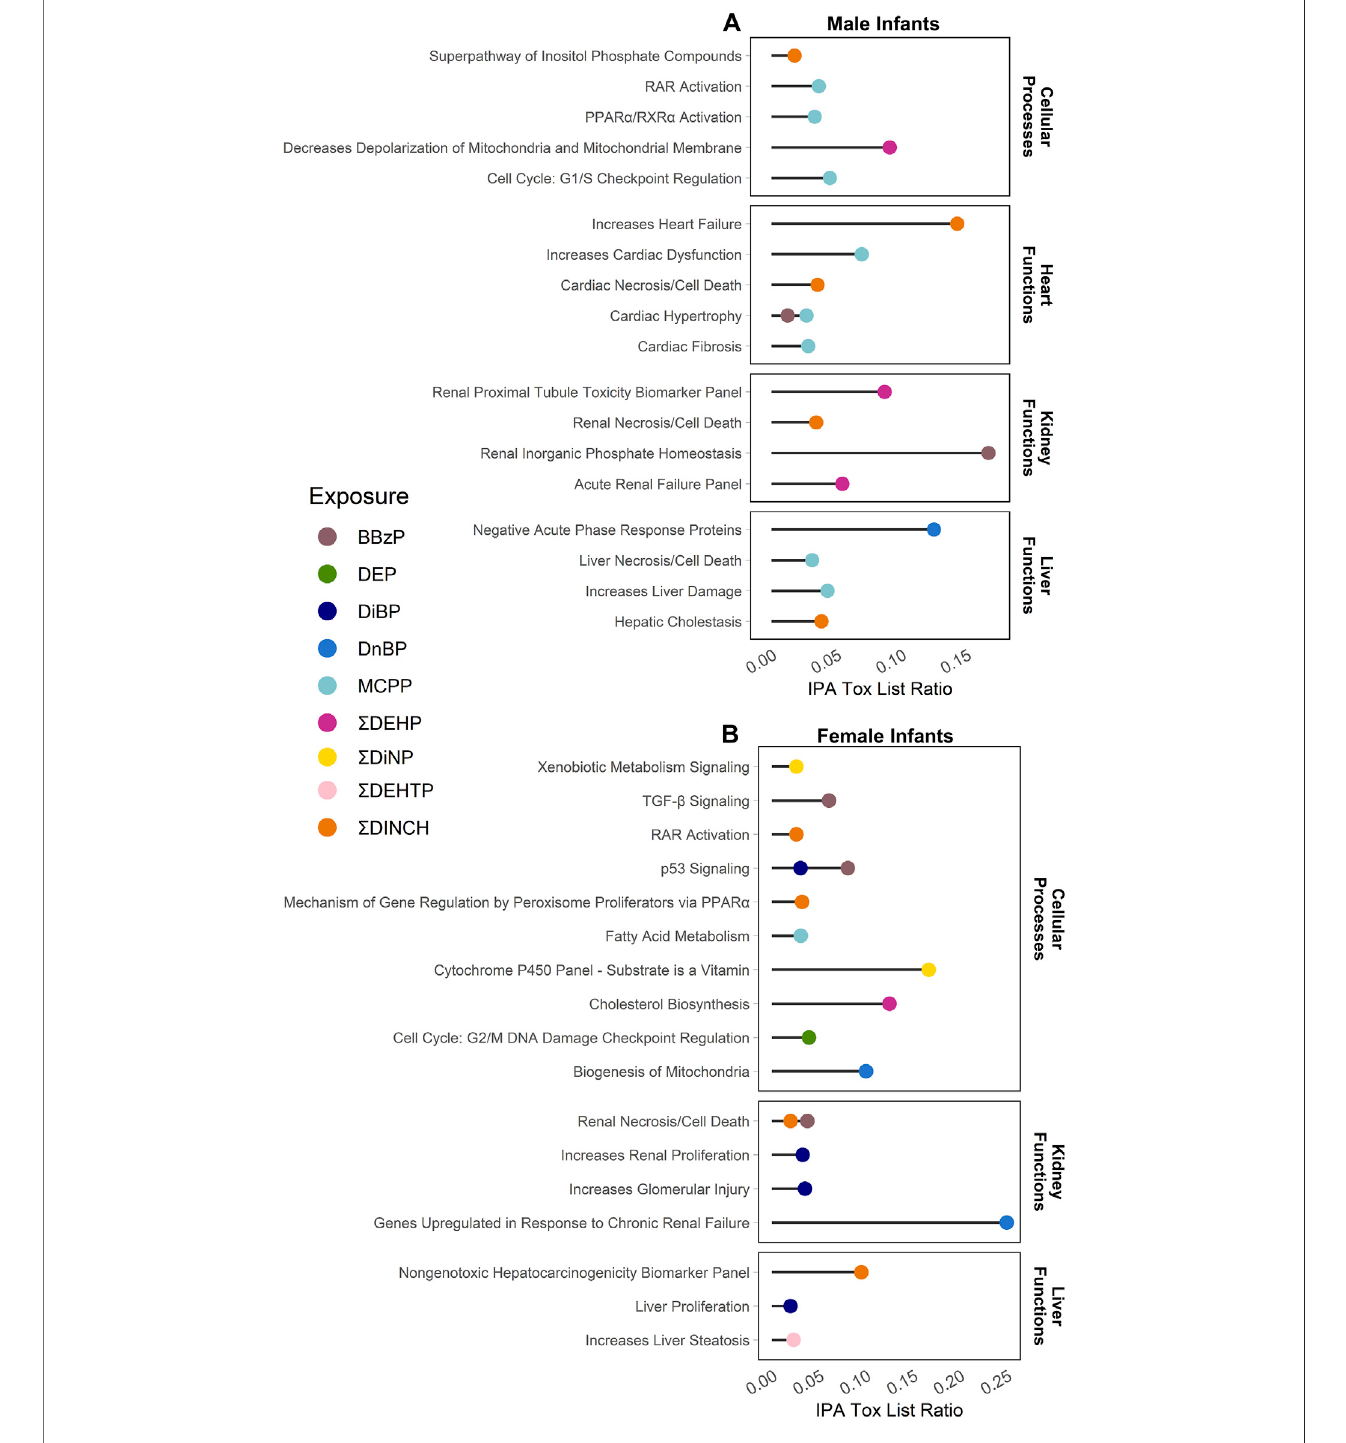
FIGURE 3 | Signi fi cantly enriched pathways from the IPA Tox Lists by infant sex. Top panel (A) shows results from males, bottom panel (B) shows results from females. Using CpGs with a raw p -value < 0.001, the % of genes enriched in each pathway are reported by individual phthalate or phthalate alternative. Only human pathways with a p < 0.05 from the pathway analysis are included in the fi gures. Full gene lists can be found in Supplement 6.